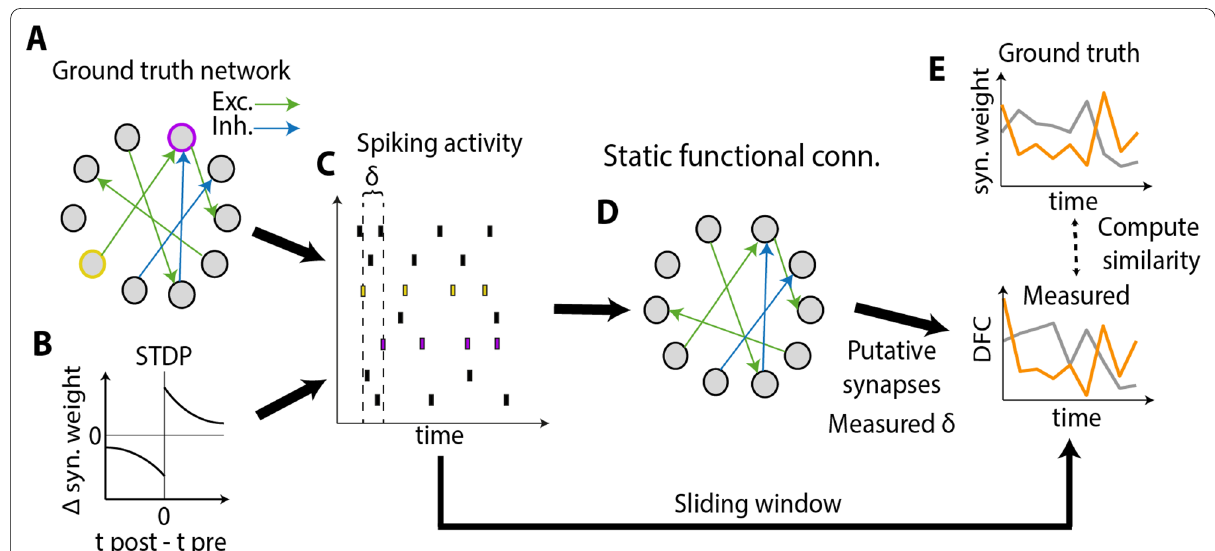
Fig. 1 Graphical depiction of the method. A Structural connectivity of the simulated network for N 10 neurons. Synaptic weights could be either = excitatory (green) or inhibitory (blue). Excitatory connections had randomly distributed communication delays. B The strength of the synaptic weights changed over time due to STDP. C Structural and biophysical properties of the network determined the spiking activity of the neural population. The presence of an excitatory (inhibitory) synapse between pairs of neurons (such as the yellow and the purple one) generates spike trains that are correlated (anticorrelated) over time with a delay δ . D Static FC was measured from spiking activity. E DFC was measured from pairwise activity measures, additionaly leveraging on the inferred static connectivity of the network, and compared to ground truth temporal evolution of synaptic weights (two example synapses are shown as orange and grey